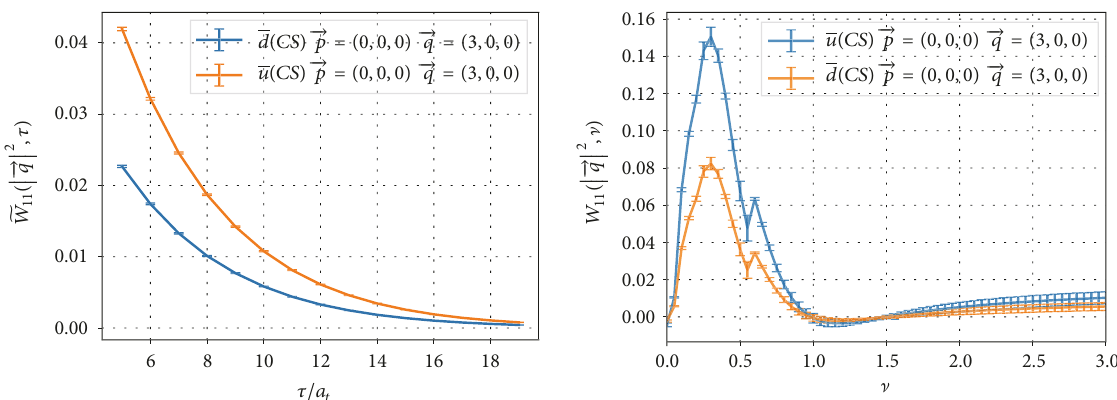
Figure 32: Euclidean (left) and Minkowski (right) hadronic tensor obtained in the study of [63]. Source: [63], reprinted with permission